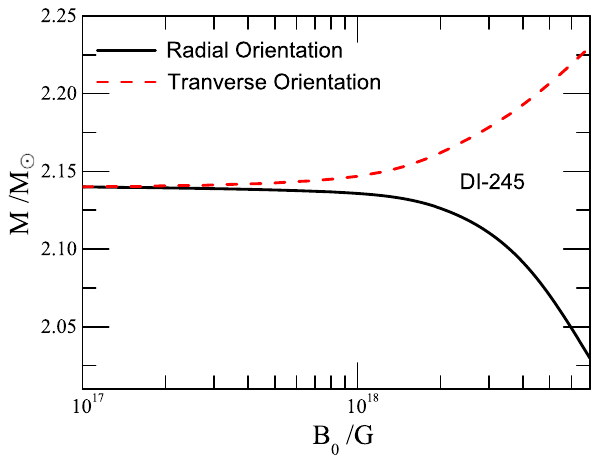
Fig. 4 Maximum mass of QSs using different orientation distributions of the magnetic fields inside the quark star as a function of B 0 with the fast B-profile with DI-245